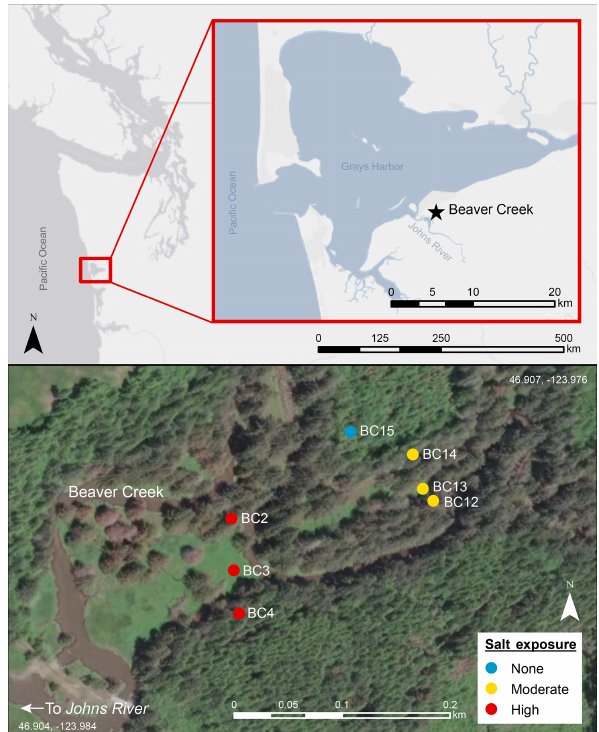
Figure 1. Study site Beaver Creek on the Olympic Peninsula in western Washington. The creek is a first-order stream, with tidal exchange restored in 2014. Top panel shows site location in west- ern Washington, with inset panel zoomed in to show the site close to Johns River. Bottom panel shows soil sampling locations at the high salt-exposure (BC2, BC3, and BC4) transect, moderate salt- exposure (BC12, BC13, and BC14) transect, and terrestrial upland (BC15) site. The transects with six sampling sites experience pe- riodic inundation episodes which result in surface pooling of tidal water. Map was created using ArcGIS 10.5 software (ESRI,